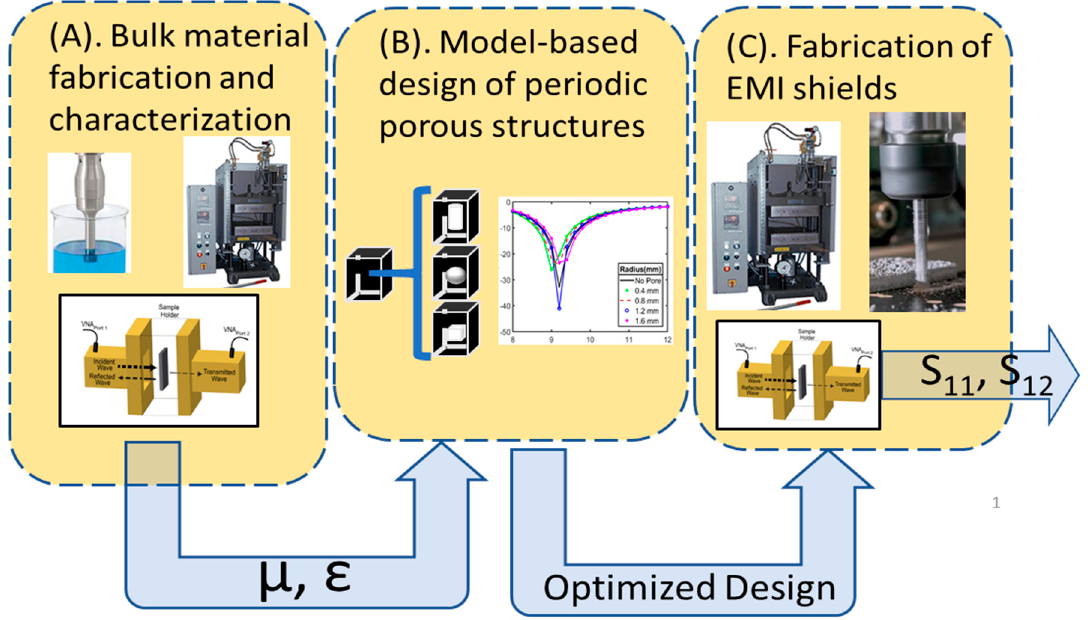
Figure 1. Three step design methodology for new EMI shields. ( A ) Composite materials are fabricated through a combination of ultrasonication and compression molding. Complex electromagnetic properties are extracted using a VNA. ( B ) Measured complex electromagnetic parameters are used in the COMSOL environment to optimize periodic porous geometry. ( C ) Optimized geometries are fabricated using a combination of compression molding and CNC milling. Final EMI shielding properties are measured and tested once more in a VNA.